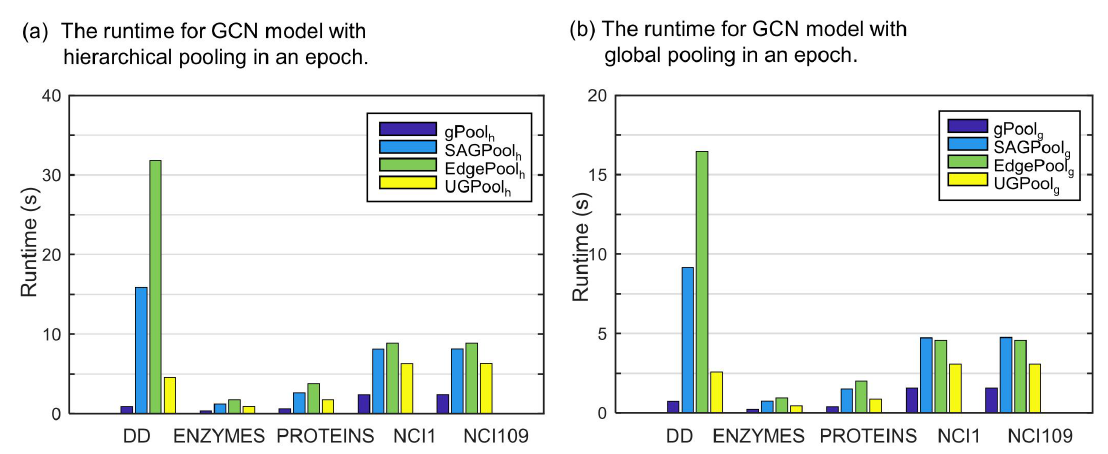
Figure 2. The runtime of different models in a training epoch on different dataset, respectively.